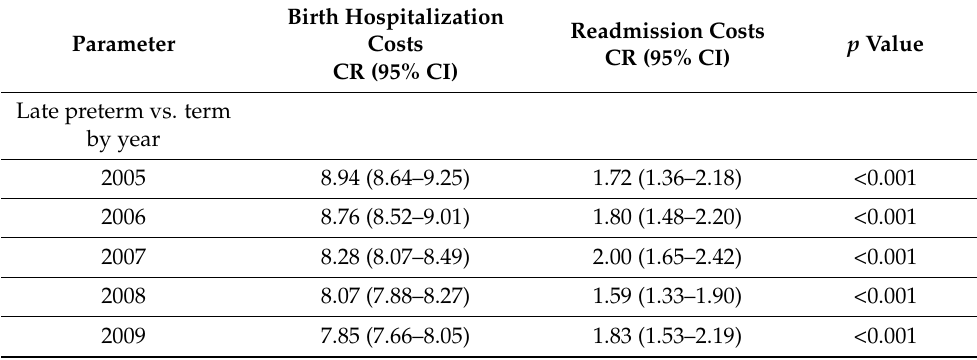
Table 3. Cost Ratios (late preterm vs. term infants) from fitted regression model for birth hospitaliza- tion and readmission costs from 2005 to 2016.